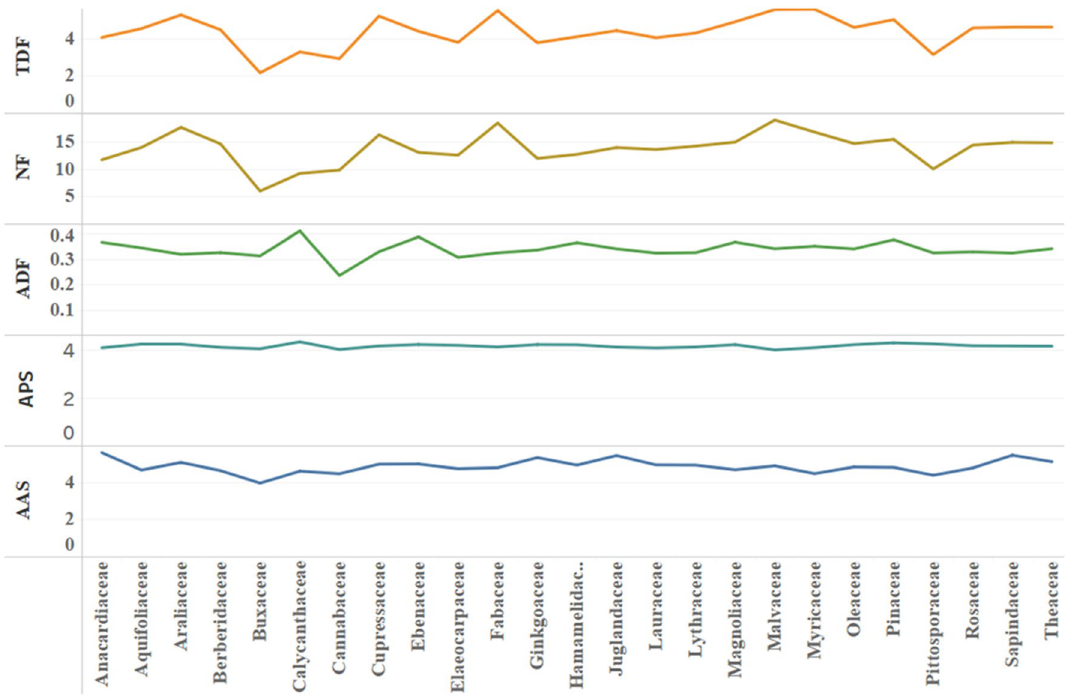
Figure 3. Statistical analysis of eye movement index mean description in different families. Note: TDF: Total duration of fixations; NF: Number of fixations; ADF: Average duration of fixations; APS: Average pupil size; AAS: Average amplitude of saccades.